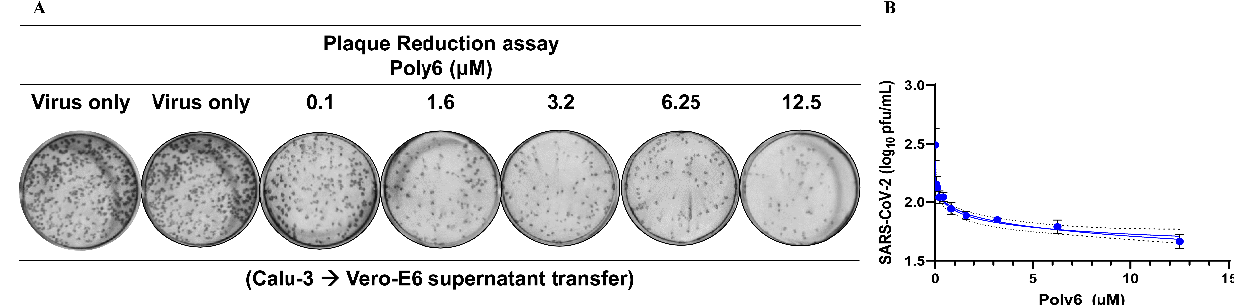
Figure 3. Infection of Calu-3 cells and virus quantification by the plaque assay in Vero-E6 cells. Calu-3 cells were infected with SARS-CoV-2 (MOI = 1). At 40 hpi, the supernatant was collected, and the virus quantified by the plaque assay in Vero-E6. ( A ) Plaque reduction assay. ( B ) Graph shows dose–response curve of Poly6 antiviral activity using 1 MOI virus inoculum. Values are mean ± SD of duplicate readings.